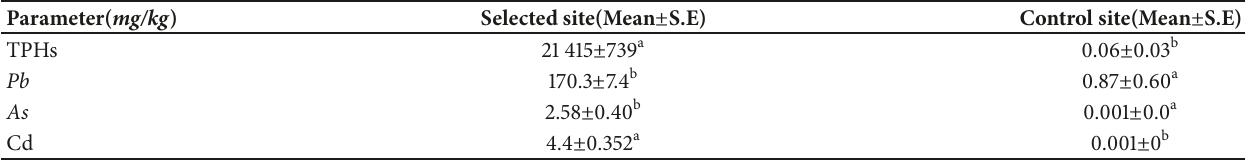
Table 1: Comparison of TPHs, Pb , As, and Cd concentration on the selected and control sites.